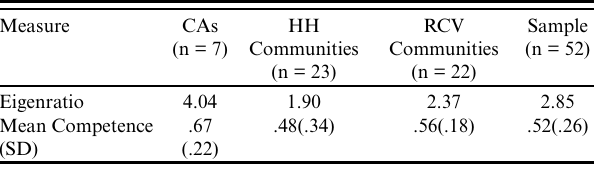
Table 1 . Cultural consensus analysis for dichotomous data. (CA = conservation agents, HH = Huilo Huilo Reserve, RCV = Valdivian Coastal Reserve)